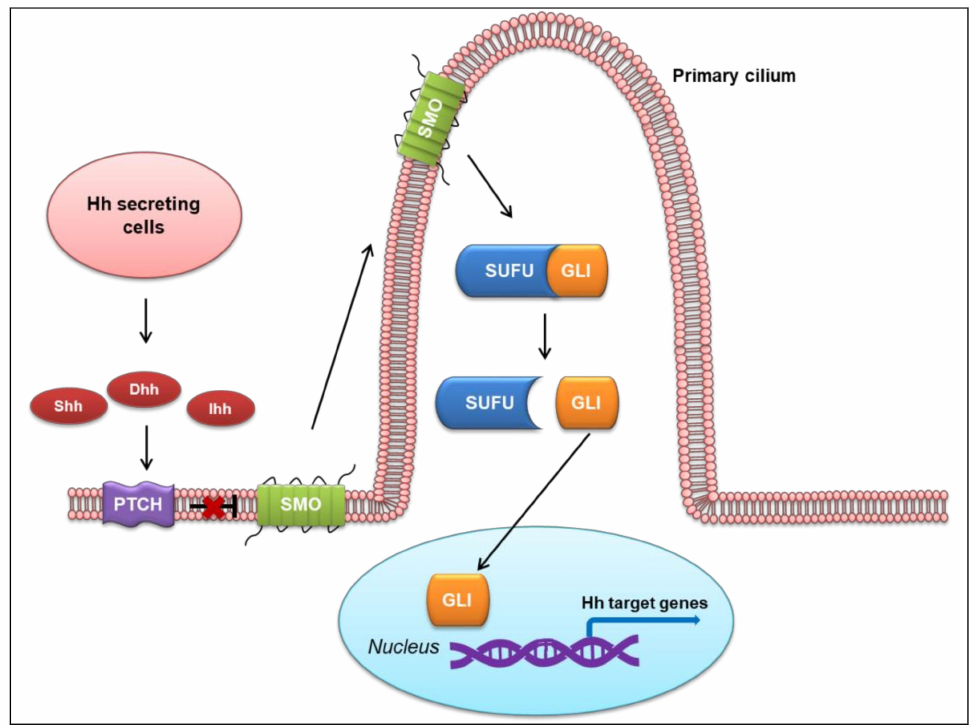
Figure 1. Canonical Hedgehog (Hh) signaling pathway in vertebrates. Shh, sonic hedgehog; Dhh, desert hedgehog; Ihh, Indian hedgehog; PTCH, Patched; SMO, Smoothened; SUFU, Suppressor of fused; GLI, glioma-associated oncogene homolog